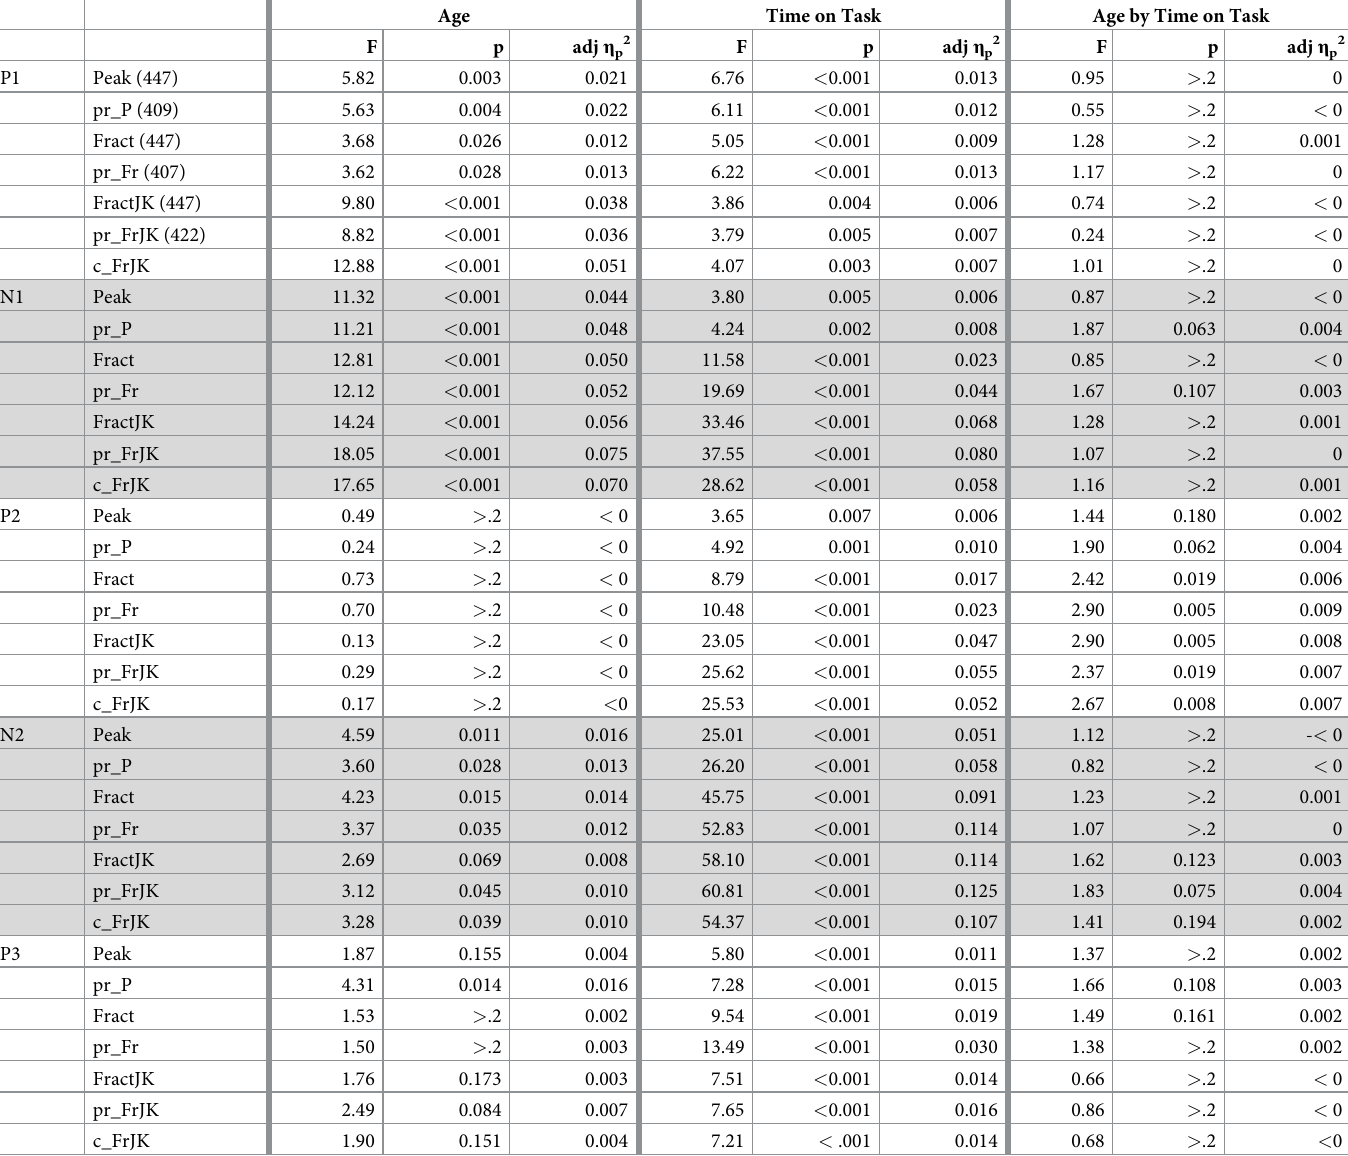
Table 1. Outcome of the mixed-design ANOVAS for peak latencies and fractional area latencies in individual averages and in jackknifed data. Data were reanalyzed after method specific reduction of the dataset based on the Standardized Measurement Error (pruned data = “pr_”). Additionally, analyses were run based on jackknife averages separately for the three age groups (cell-based = “c_”). Number of valid subjects in the analyses are given in brackets for all measures for the first component but apply to all components